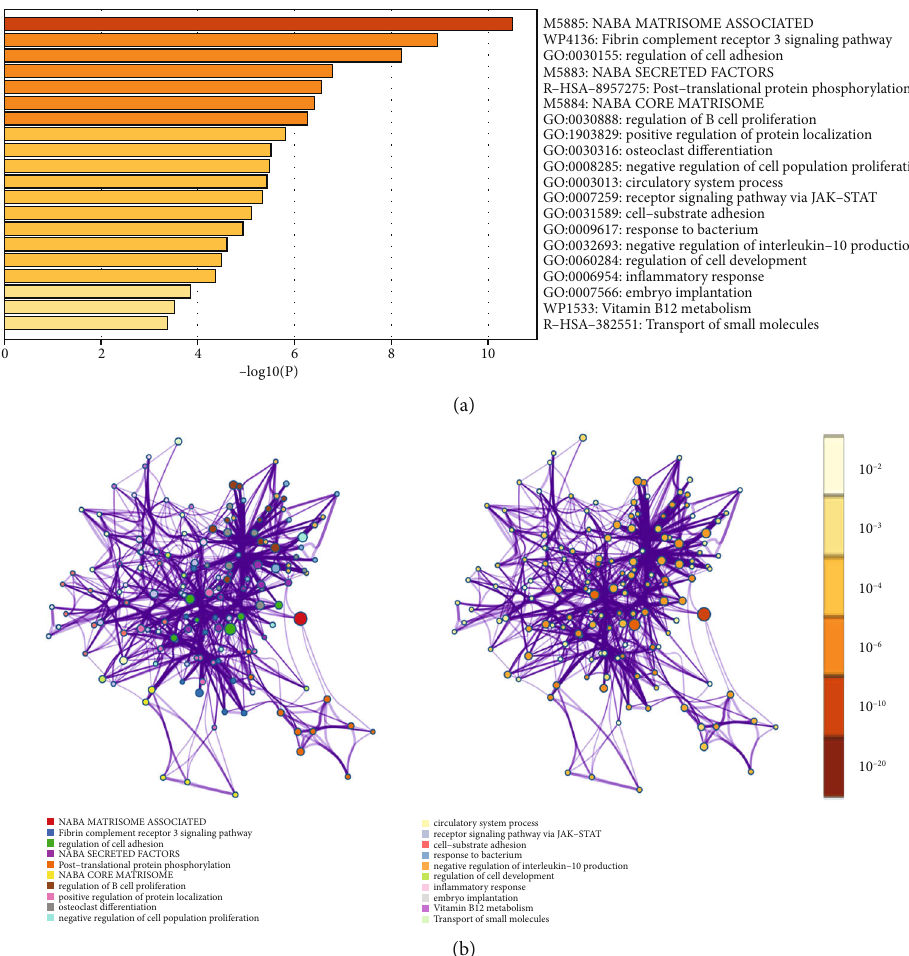
Figure 2: (a) GO and KEGG functional enrichment analyses of the secretory or membrane-associated DEGs; (b) interactions between the enriched pathways among 74 genes. The size of the dots indicates the number of genes in the relevant pathway, and the color indicates the cluster category. The pathways for the clustering category are displayed in the tab on the label. Dots representing the same enrichment pathway have di ff erent colors depending on the p value displayed on labels. The darker the color, the smaller the p value, and the more statistically signi fi cant it